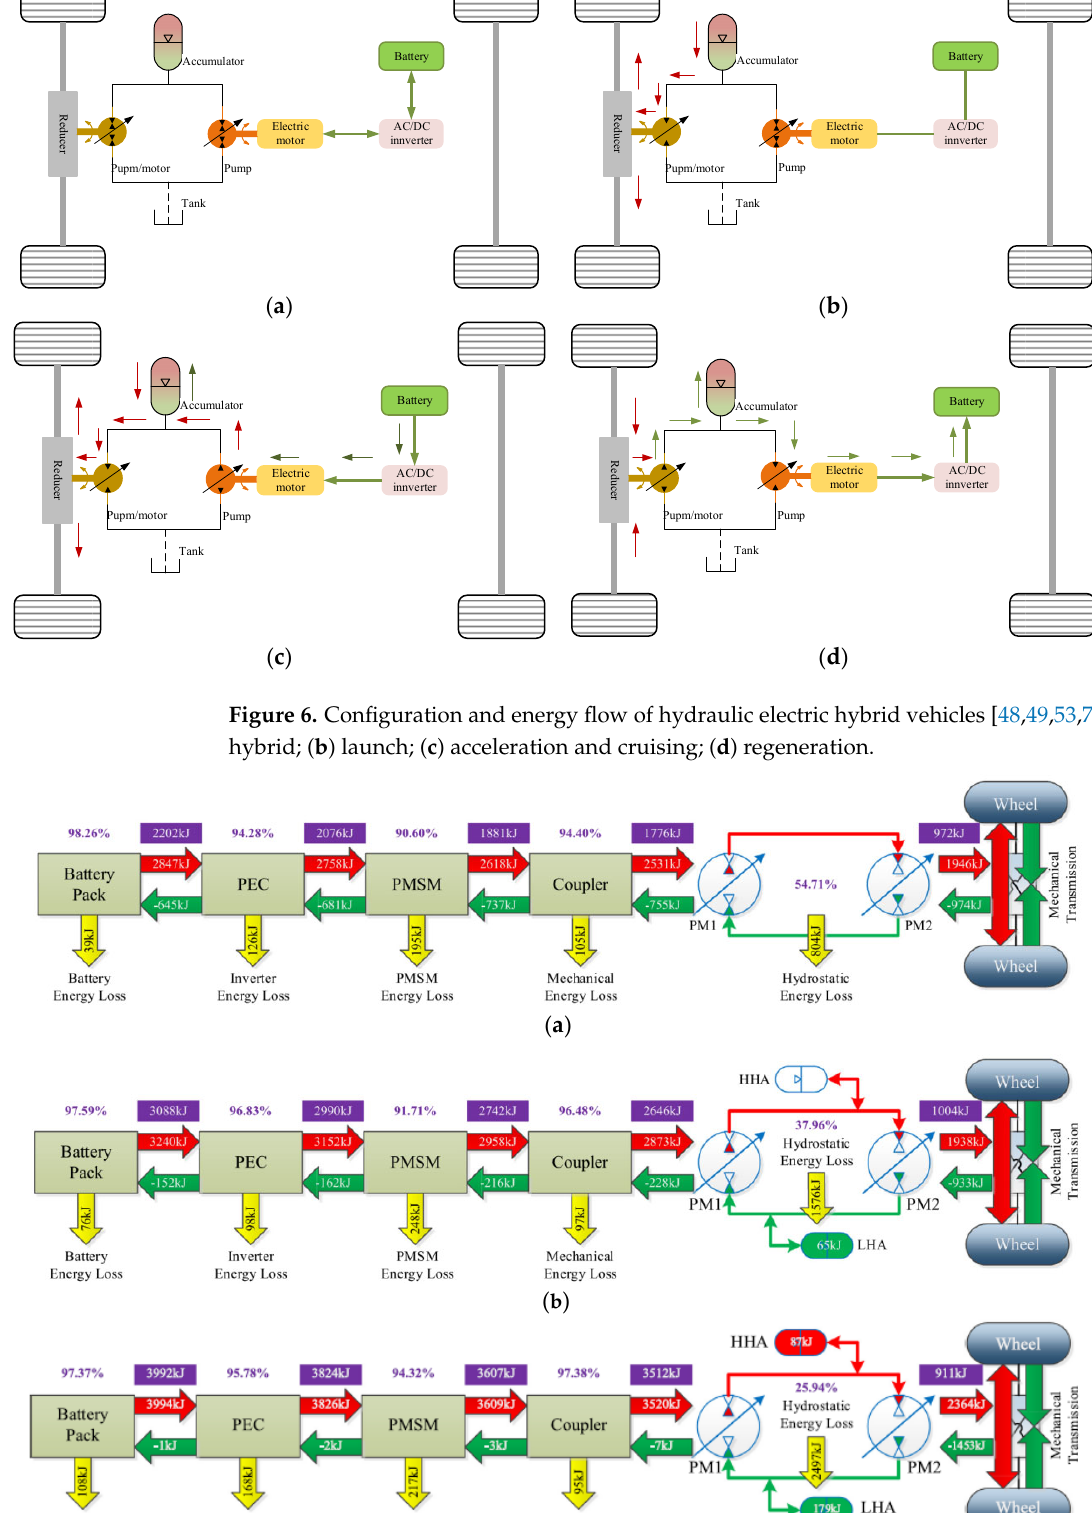
Figure 7. Configuration of energy flow and loss in the proposed hydraulic electric vehicle [56]: ( a ) battery mode; ( b ) battery ‐ accumulator mode; ( c ) accumulator mode. ( a ) battery mode; ( b ) battery-accumulator mode; ( c ) accumulator